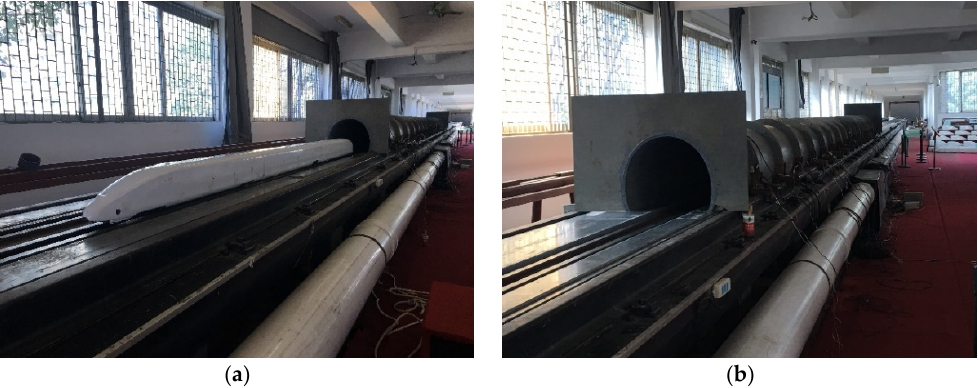
Figure 2. Moving model tests of aerodynamics in tunnels. ( a ) model train; ( b ) model tunnel.